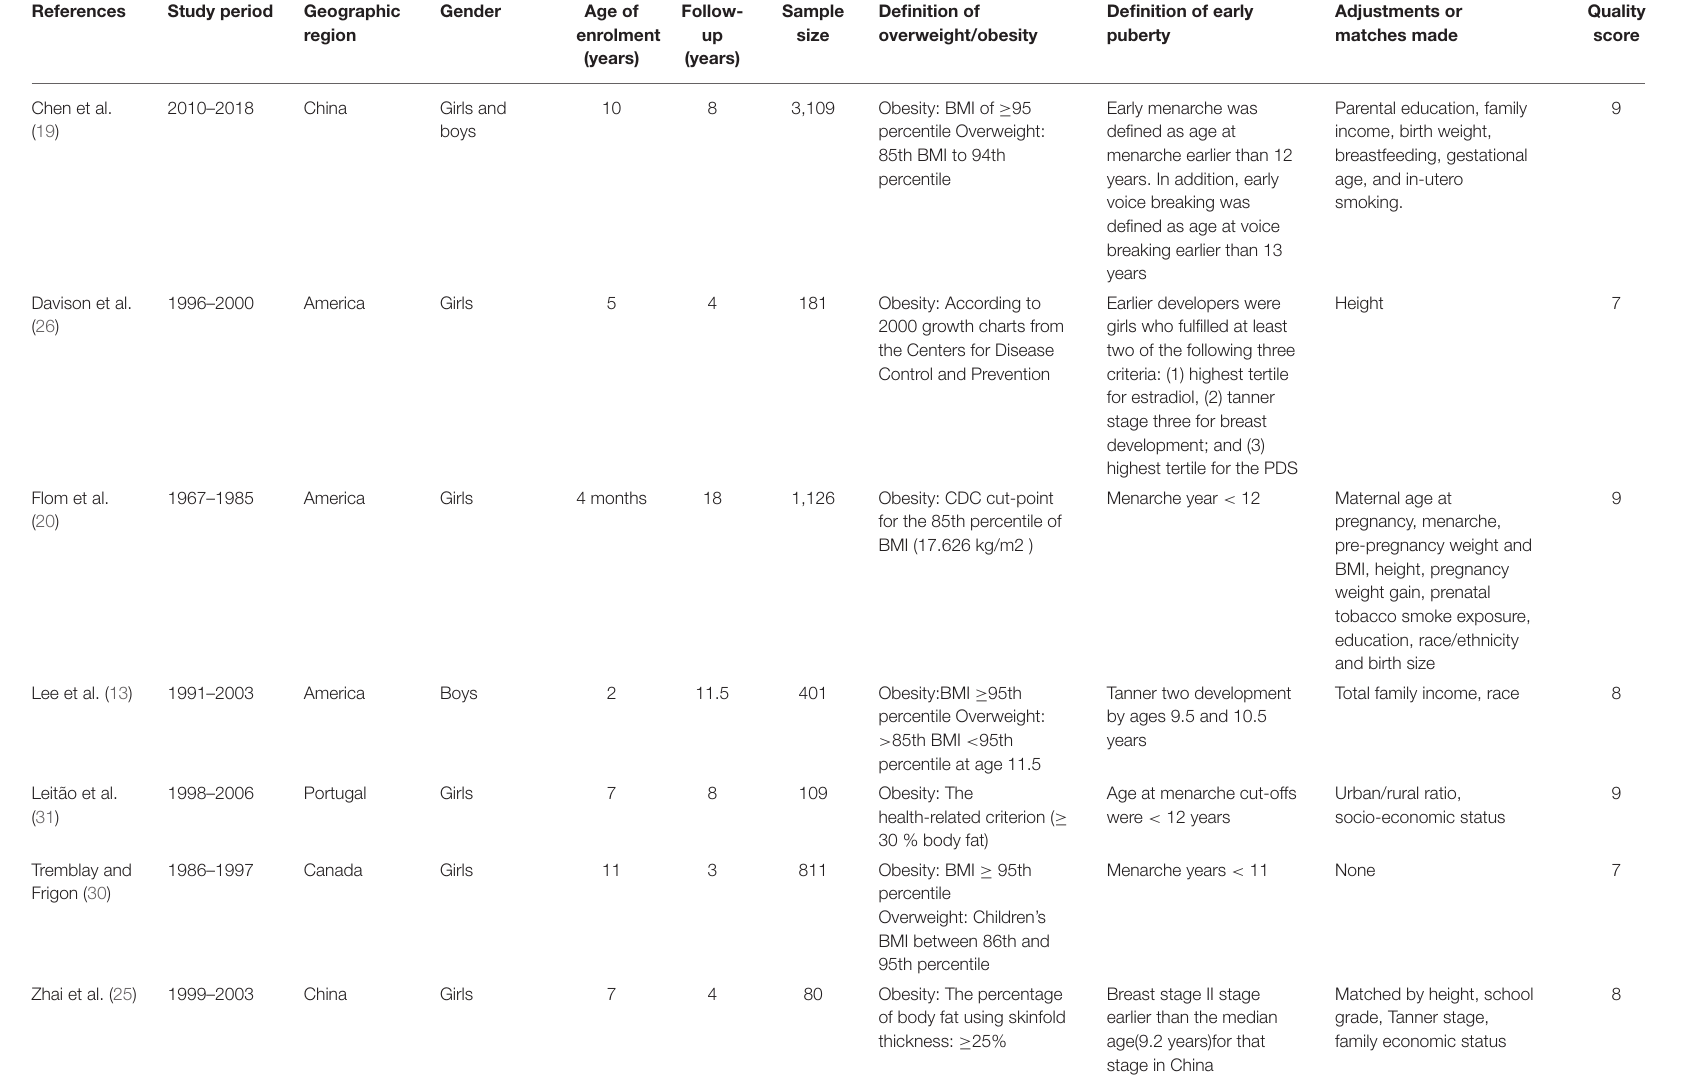
TABLE 1 | Selected characteristic of 7 cohort studies of childhood overweight/obesity and early puberty.